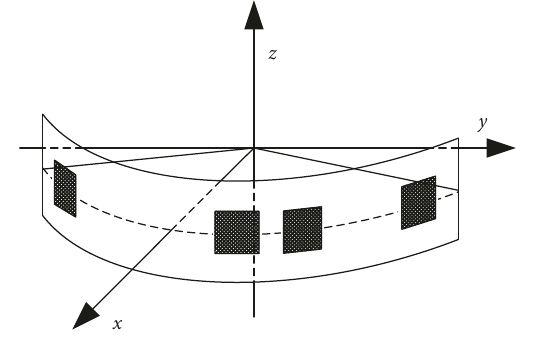
Figure 2: Arc conformal array model.